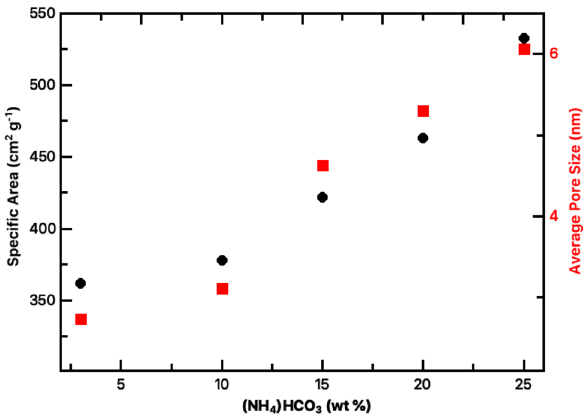
Table 2. NaOH concentrations used in the preparation of nickel-doped aerogels with the resulting physical properties and nickel nanocrystal morphology.